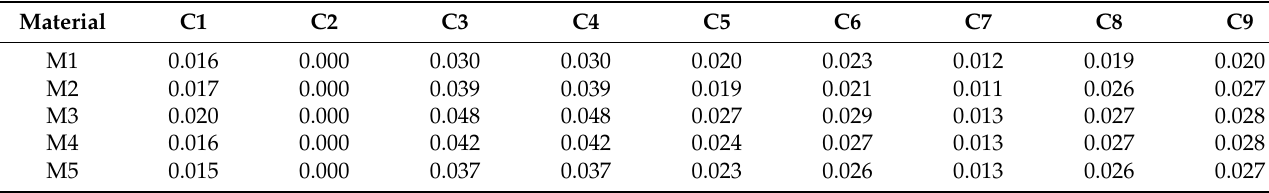
Table 15. COPRAS weighted matrix.